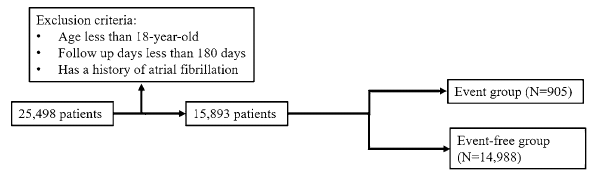
Figure 4. Study cohort. A cohort study enrolled 15,893 consecutive patients after excluding patients aged less than 18 years, followed up for less than 180 days, or having a history of atrial fibrillation. The total number